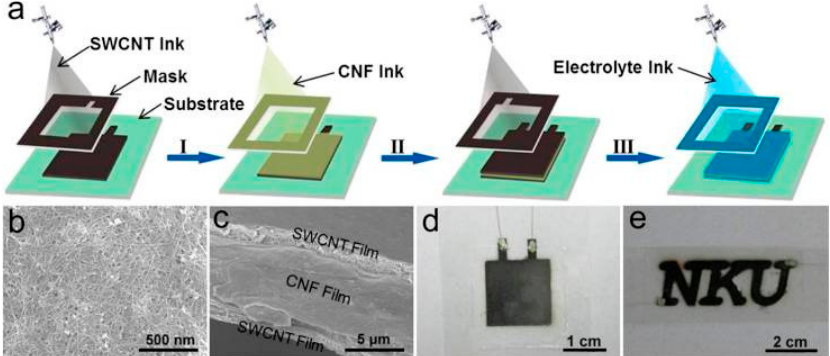
Figure 9 . Carbon nanotubes (CNTs) ink was used to prepare a full-print supercapacitor by continuous spray printing. ( a ) Process of preparing supercapacitors by continuous spray printing with CNTs ink and electrolyte ink through a template; ( b ) SEM image of the spray printed CNTs; ( c )